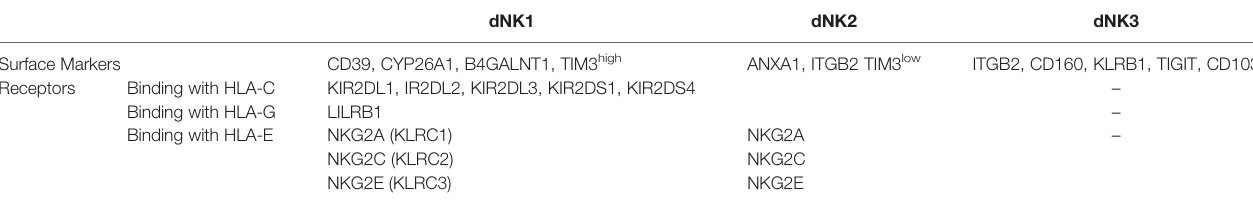
TABLE 1 | The surface markers and KIR receptors of the three dNK cells subsets.